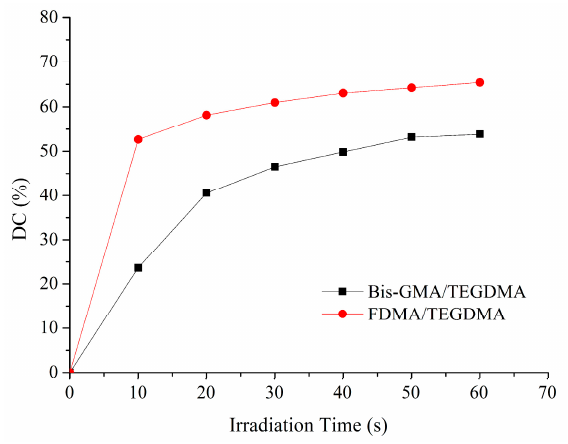
Figure 3. Proton Nuclear Magnetic Resonance ( 1 H-NMR) spectrum of FDMA.